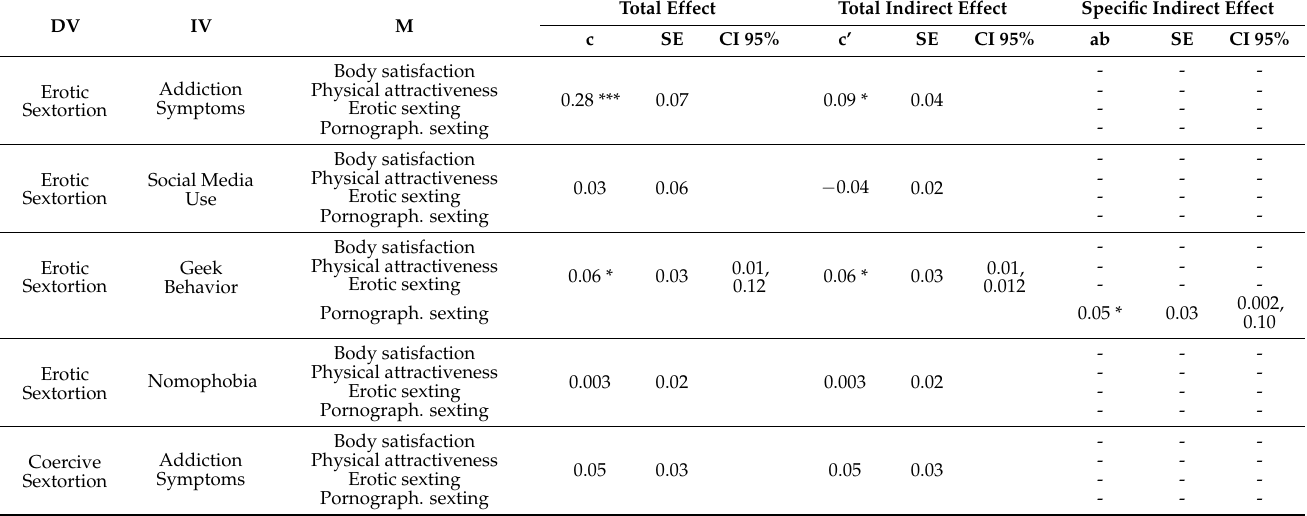
Table 3. Coefficients of total, direct and indirect effects.